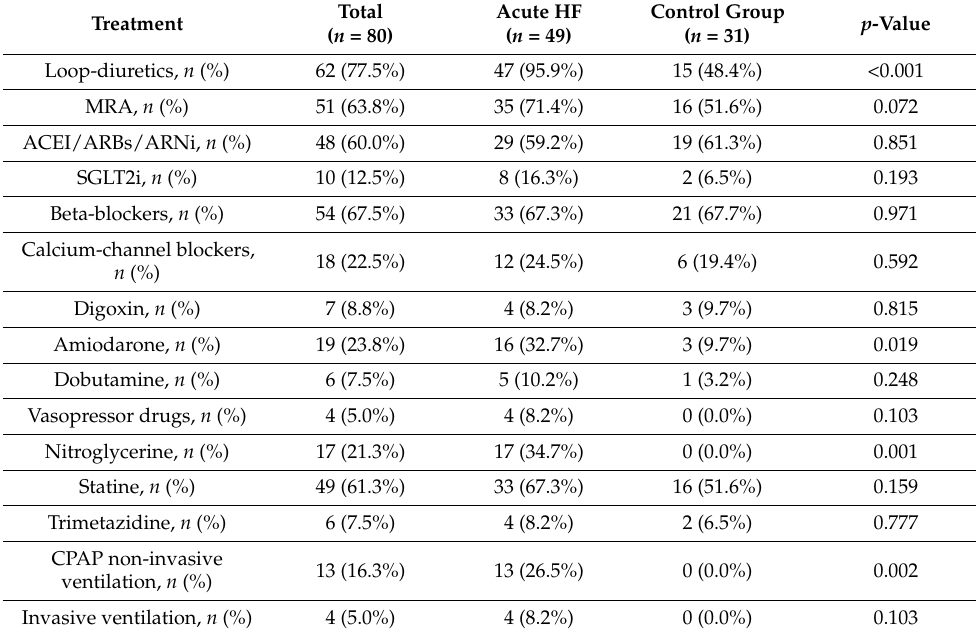
Table 2. Differences in therapy in AHF patients and control